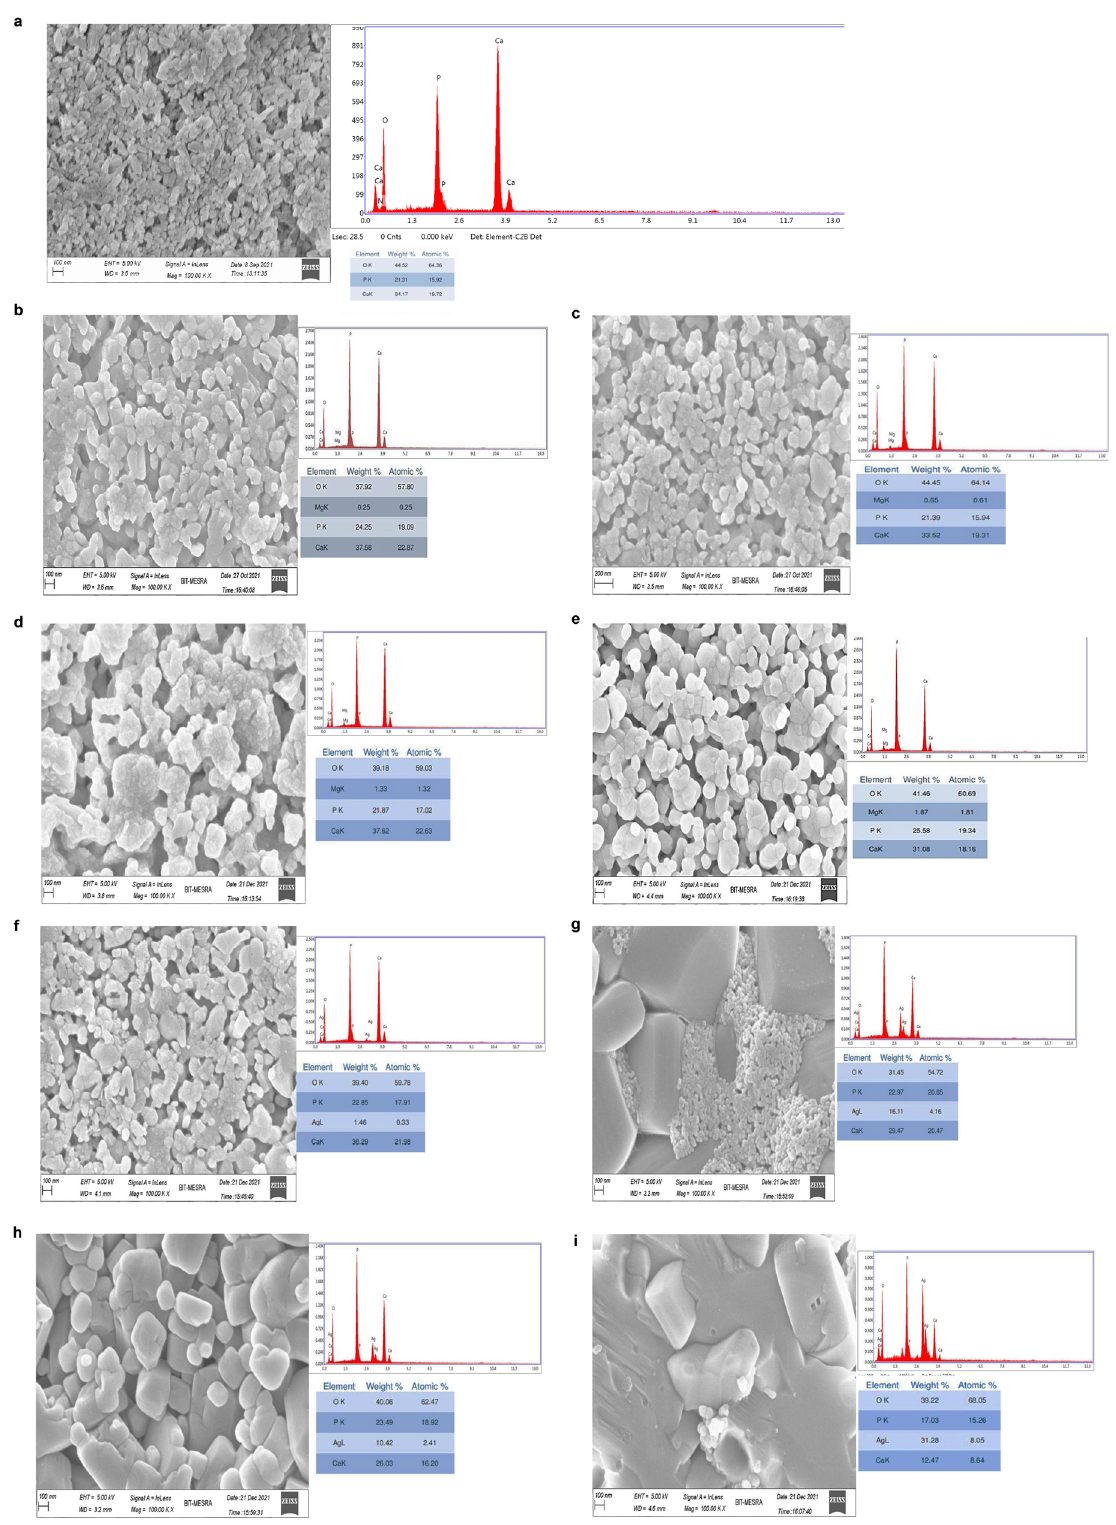
Fig. 7 a The morphology of pure HAp sample. b The morphology of 1 wt% MgHAp. c The morphology of 2 wt% MgHAp. d The mor- phology of 3 wt% MgHAp. e The morphology of 4 wt% MgHAp.